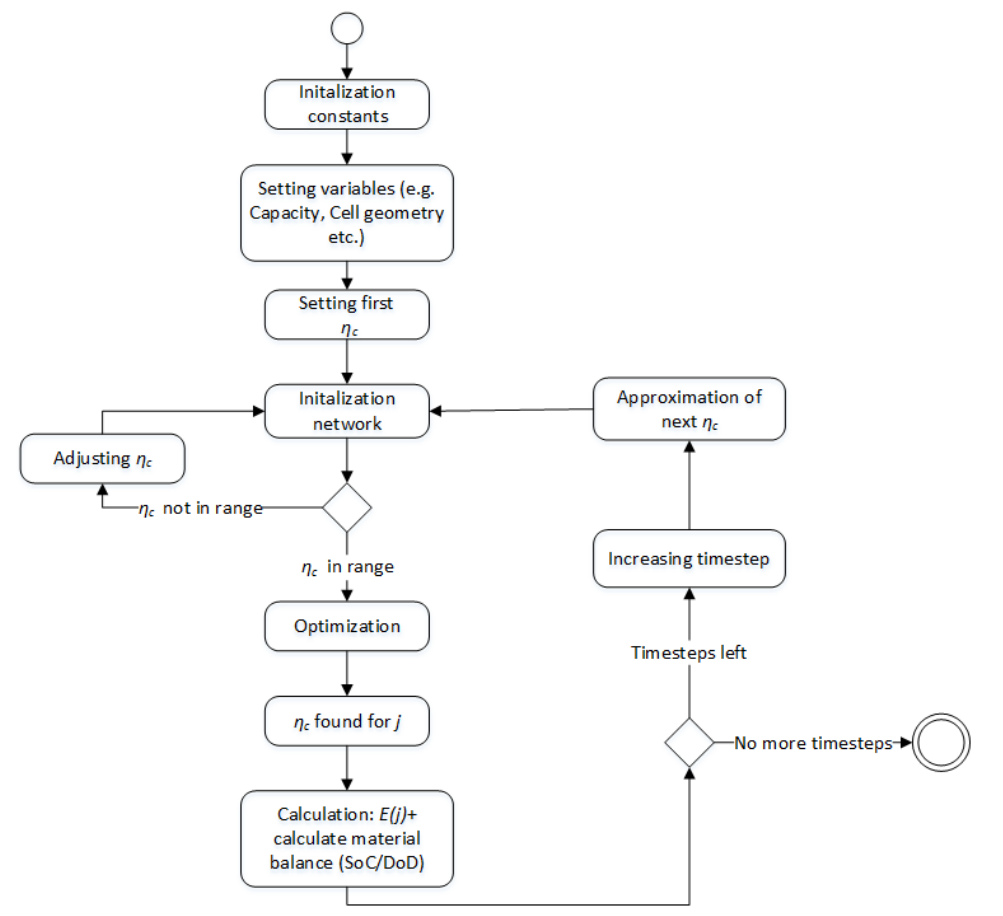
Figure 3. Activity diagram representing the implemented